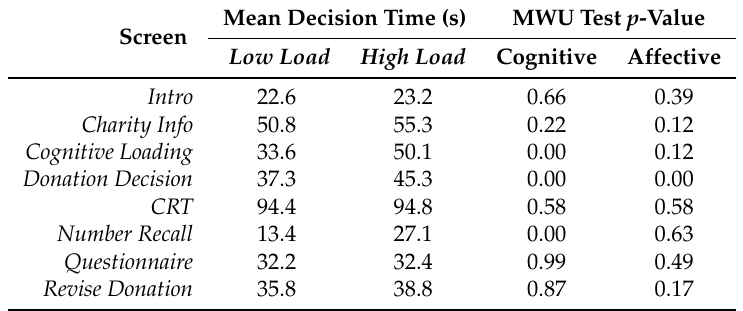
Table 1. Comparison of mean decision times for each screen across cognitive-load treatments with p -values for an MWU test of equal distributions. Also included for comparison are p -values for the comparison of the low and high affect